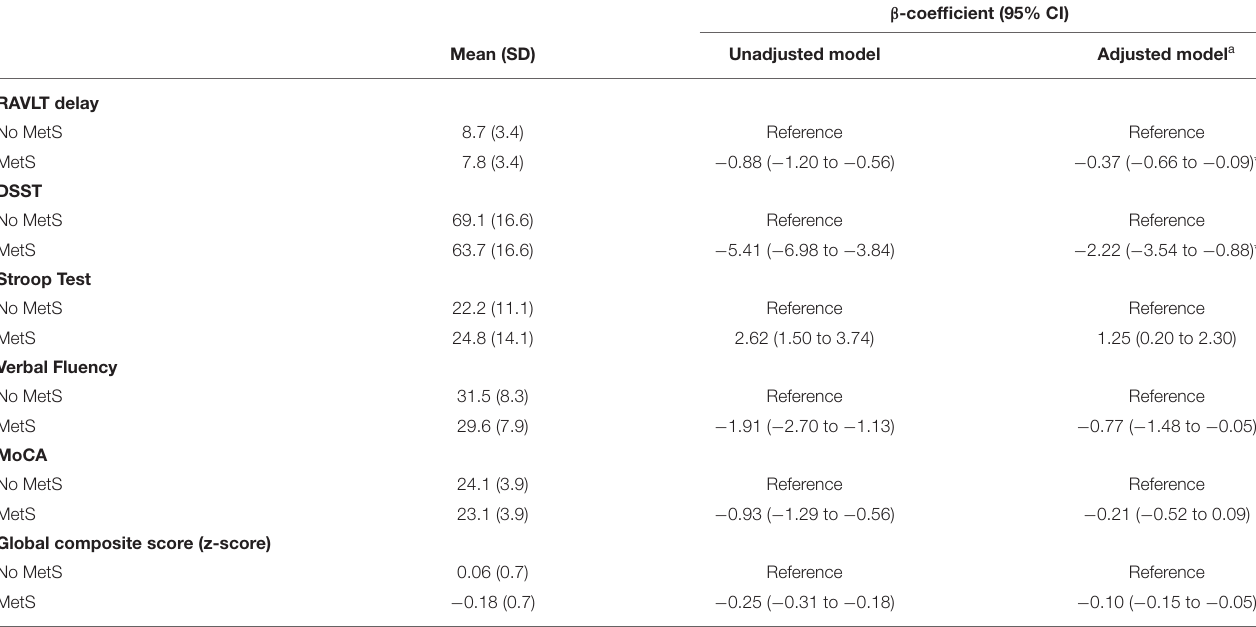
TABLE 2 | The association between midlife metabolic syndrome and cognitive performance among the 2,880 CARDIA